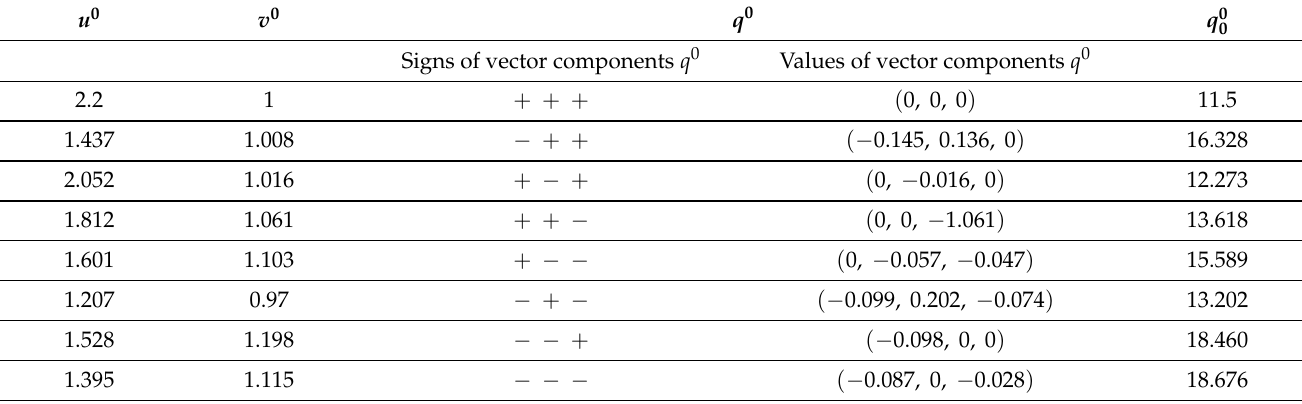
Table 3. The results of calculations when finding a solution to the problem (4) for three